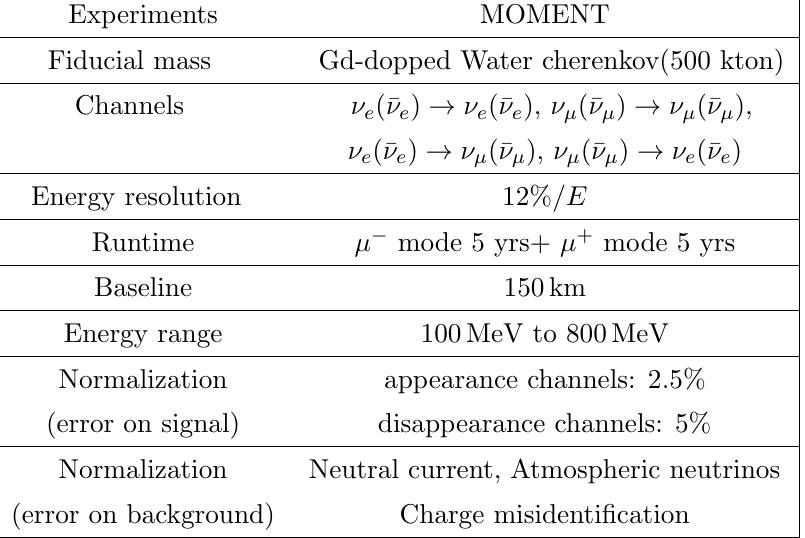
Table 1 . Assumptions for the source, detector and running time for MOMENT in the simulation.